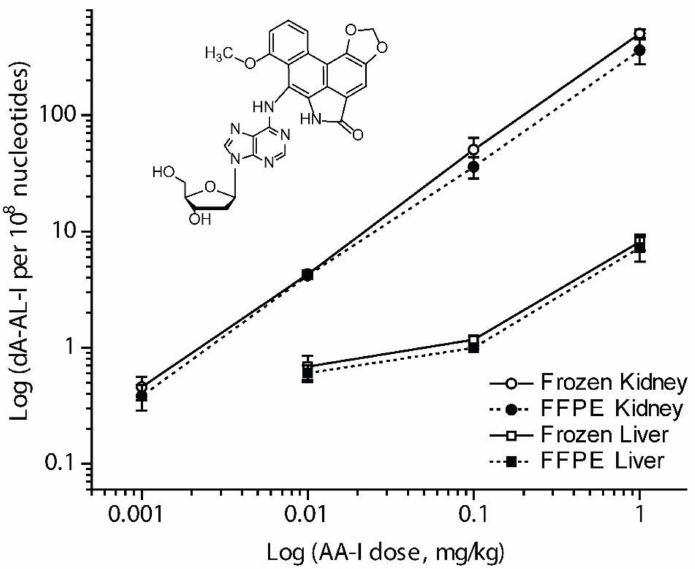
Figure 4. Mean level of dA-AL-I adducts present in mouse kidney and liver following treatment with AA-I (0.001 − 1 mg/kg body weight). Adduct levels measured in freshly frozen and FFPE mouse kidney ( and ) and liver ( (cid:3) and (cid:4) ) (mean adduct level, SD, N = 4 animals per dose, (cid:35) quadruplicate measurements per animal) were plotted as a function of dose. The overall mean difference in adduct levels between freshly frozen and FFEP kidney and liver tissues across all doses was 21 ± 14% (mean ± SD). dA-AL-I adduct formation was below the limit of detection in liver of mice dosed with AA-I at 0.001 mg/kg body weight. Mean levels of dA-AL-I adducts were significantly statistically different between freshly frozen and FFPE kidney or liver at the following dose treatments of AA-I: kidney, 1 mg/kg, p = 0.03; liver, 0.1 mg/kg, p = 0.01; unpaired two-tailed t -test. Reproduced with permission from [104]. Copyright ACS,